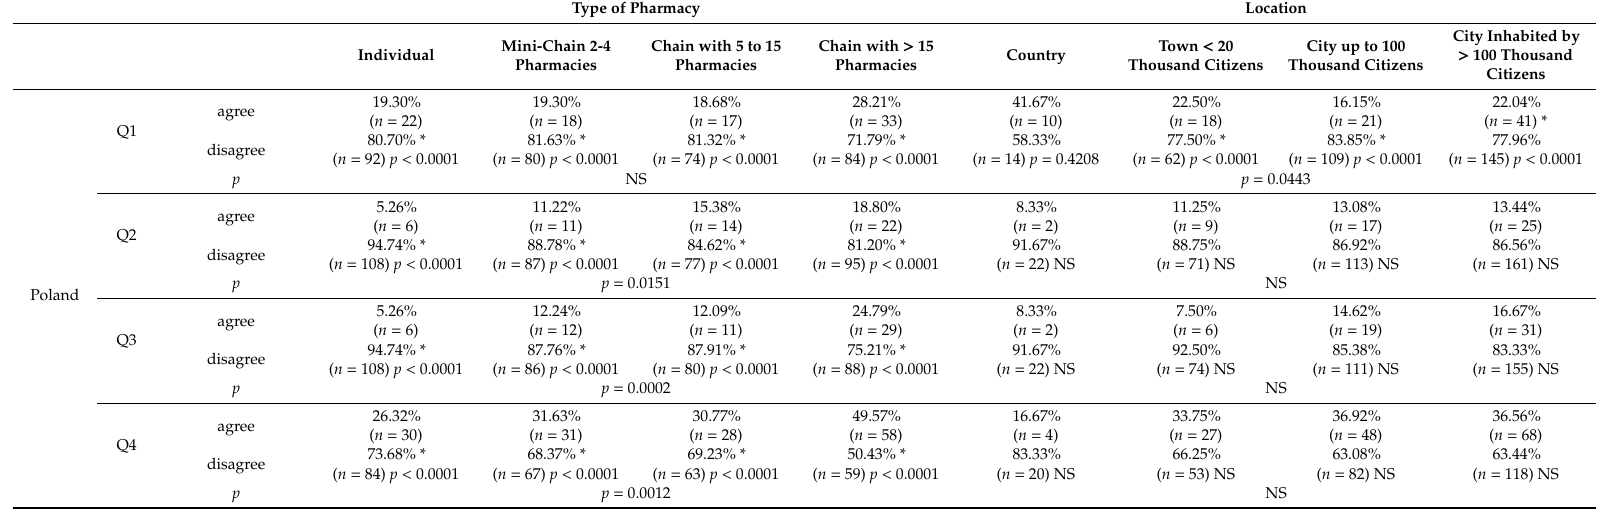
Table 4. Data distribution in relation to the type of pharmacy and their